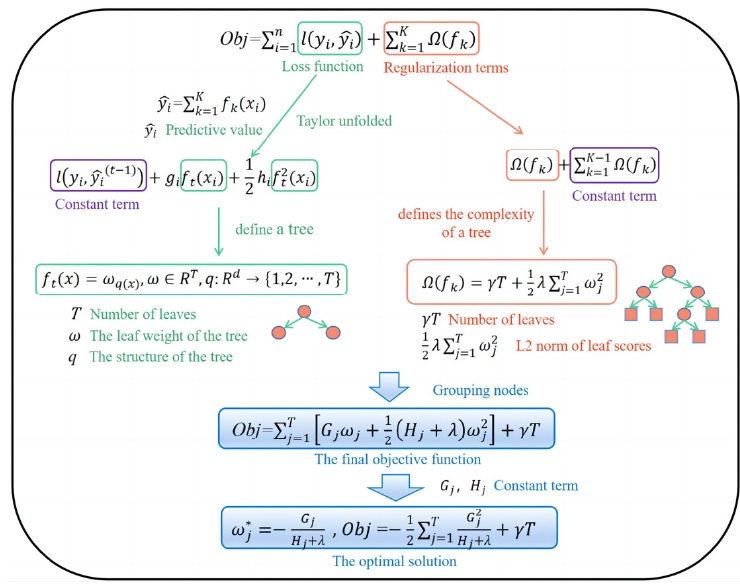
Figure 5. XGBoost algorithm derivation flowchart.